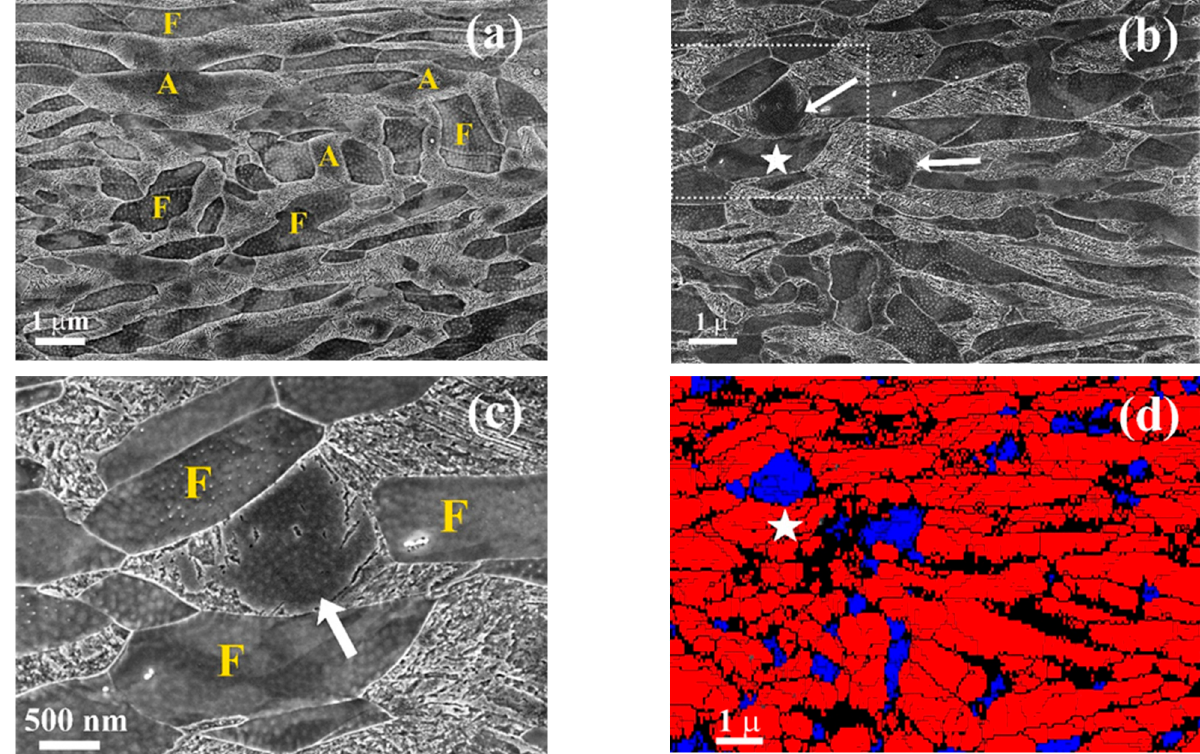
Figure 5. SEM micrographs showing the microstructures of specimens tested to fracture at ( a ) 100 °C and ( b ) 125 °C. Arrows in ( b ) marked areas of untransformed austenite. ( c ) is a higher magnification of the area highlighted by the dotted line in ( b ). The arrow marks an untransformed austenite area. ( d ) EBSD phase map of ( b ) showing some areas of retained austenite after the tensile test. F: ferrite, A: austenite. Blue color represents fcc phase, red color represents bcc phase, and black color represents unindexed points. White stars are registration marks.